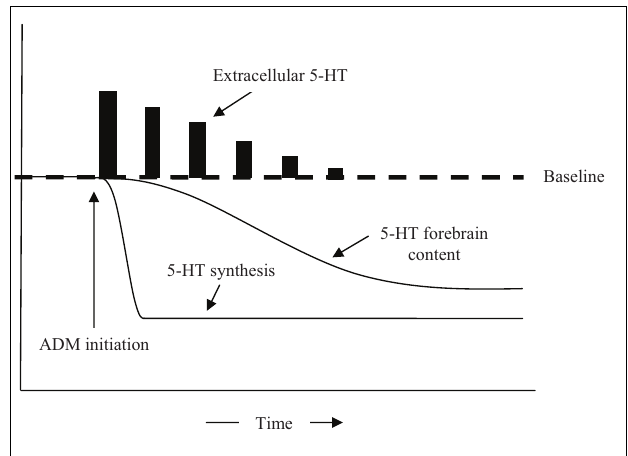
FIGURE 1 |The effects of antidepressant medications on extracellular levels of serotonin, the synthesis of serotonin, and overall forebrain levels of serotonin, as a function of